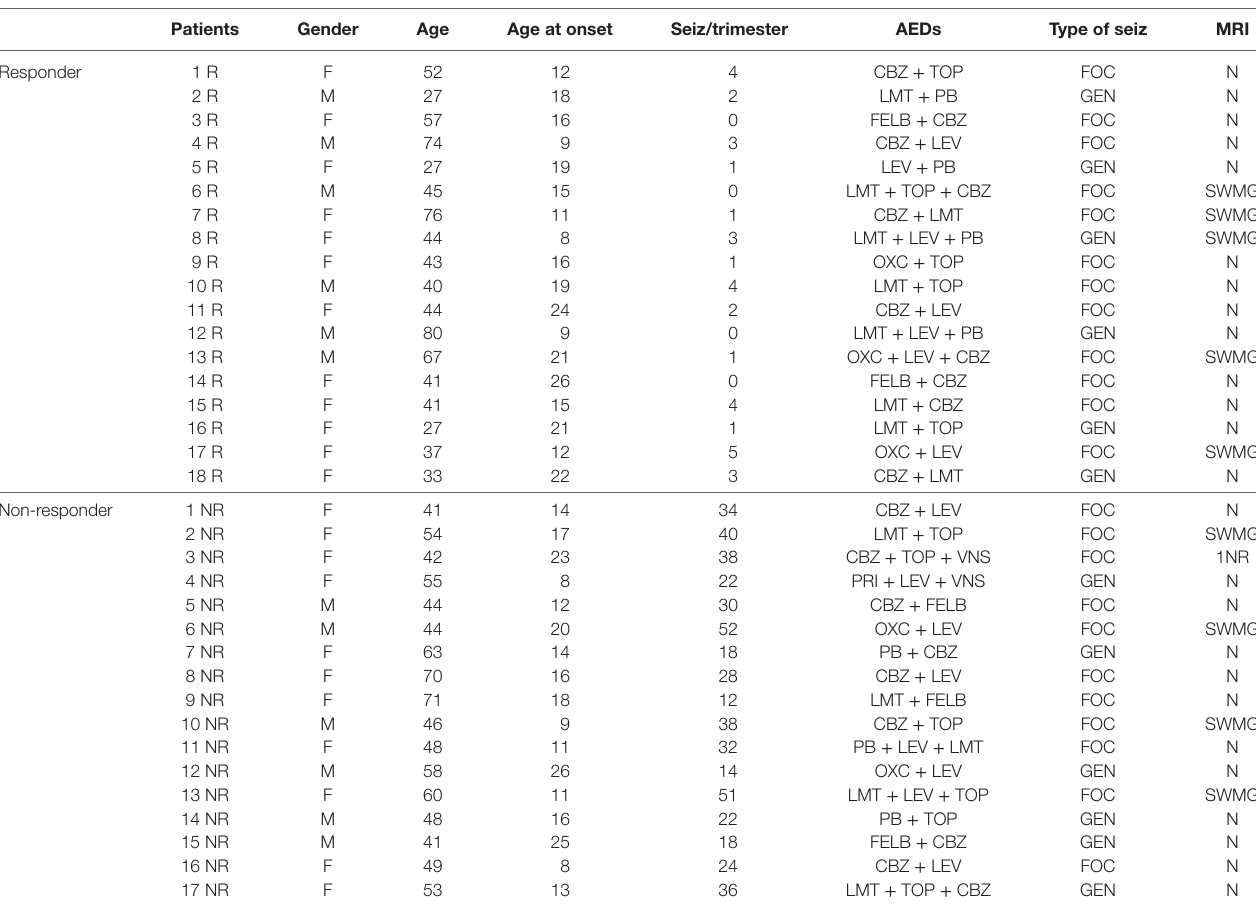
TaBle 2 | Summary of the epileptic patients enrolled in the study: responders (R) and non-responders (NR) under therapy with AEDs. Patients gender age age at onset seiz/trimester